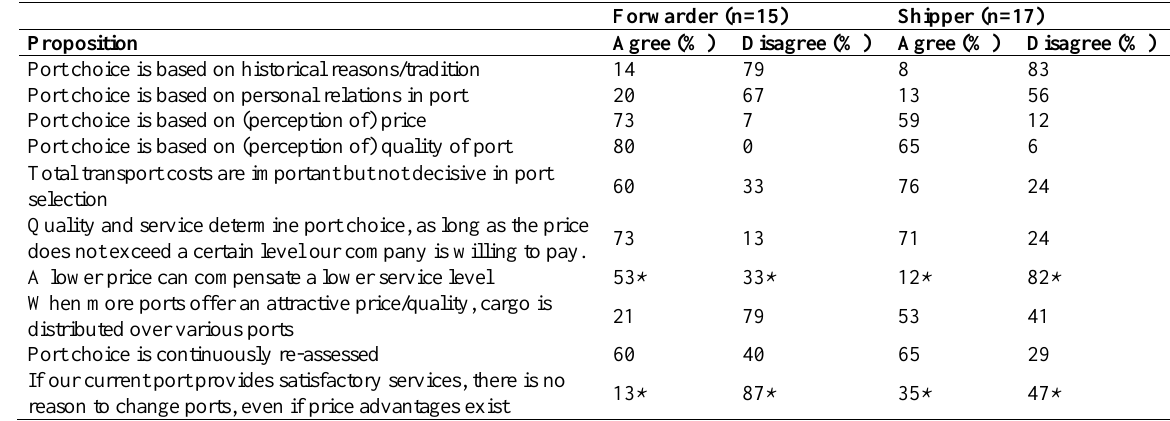
Table 2. Responses to a number of port selection propositions